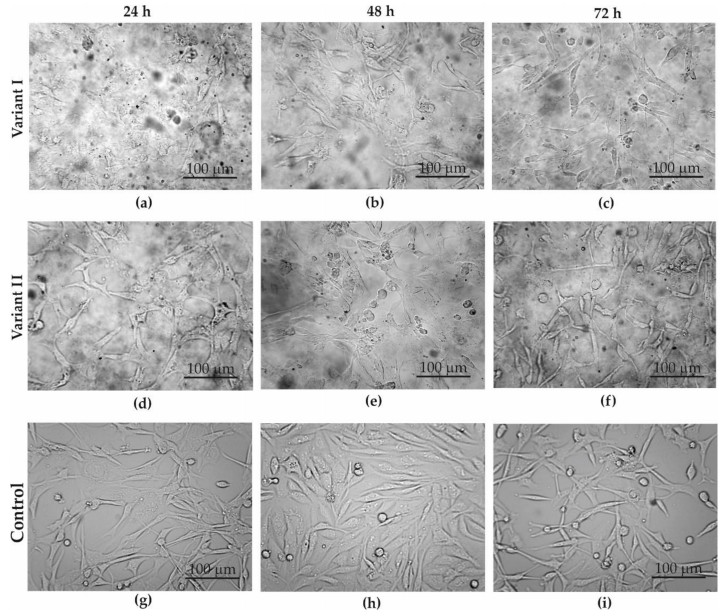
Figure 5. Optical microscope images of MDA-MB-231 cell culture in: ( a – c ) variant I; ( d – f ) variant II; ( g – i ) control; after: 24 ( a , d , g ), 48 ( b , e , h ), and 72 h ( c , f , i ).